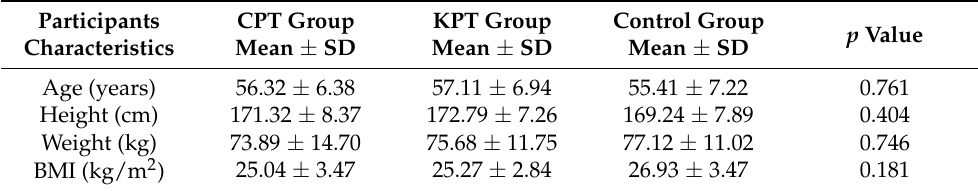
Table 1. Participants characteristics of age, height, weight and BMI.